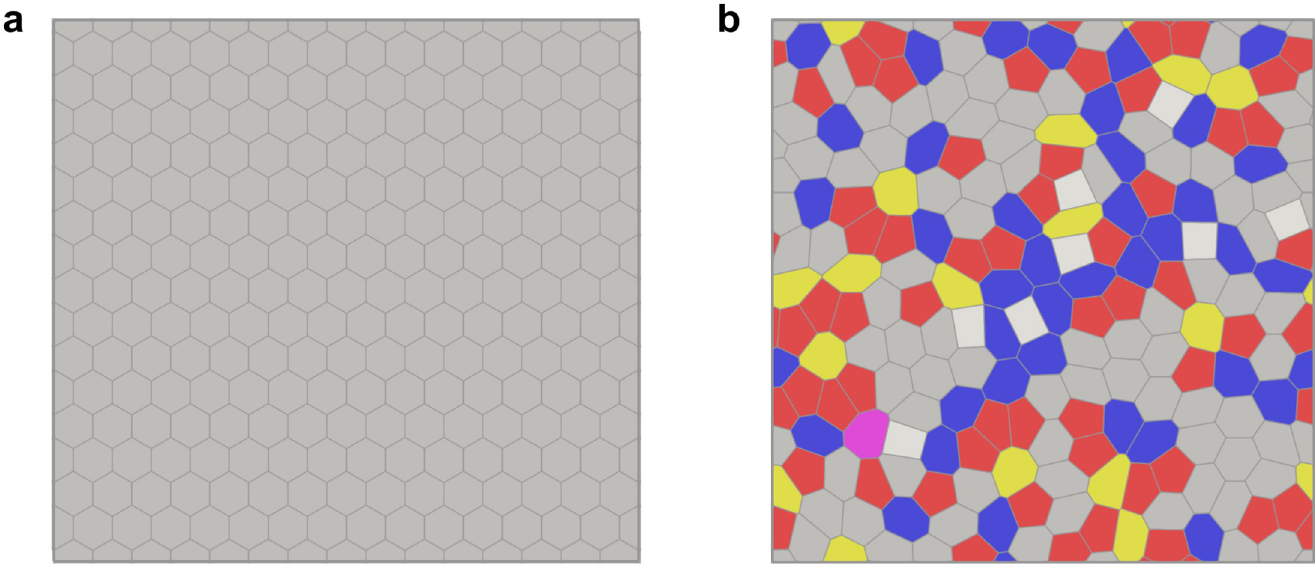
Fig 1. Epithelial tissue is represented as a polygon tiling of the plane subject to periodic boundary conditions. We studied the rheology of the vertex model for both (a) regular hexagonal and (b) disordered tilings. Colors represent the number of neighbors of each cell; 4-white, 5-red, 6-gray, 7-blue, 8-yellow.